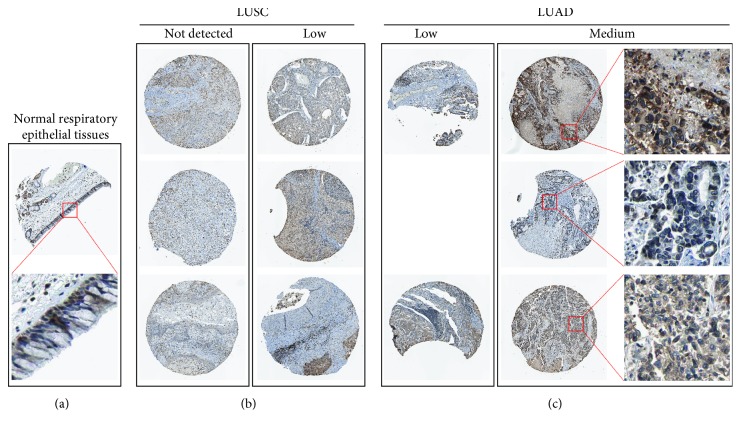

UBE2D1 protein expression in normal respiratory epithelium and LUAD and LUSC tissues. UBE2D1 IHC staining in normal respiratory epithelial tissues (a), in LUSC tissues (b), and in LUAD tissues (c).